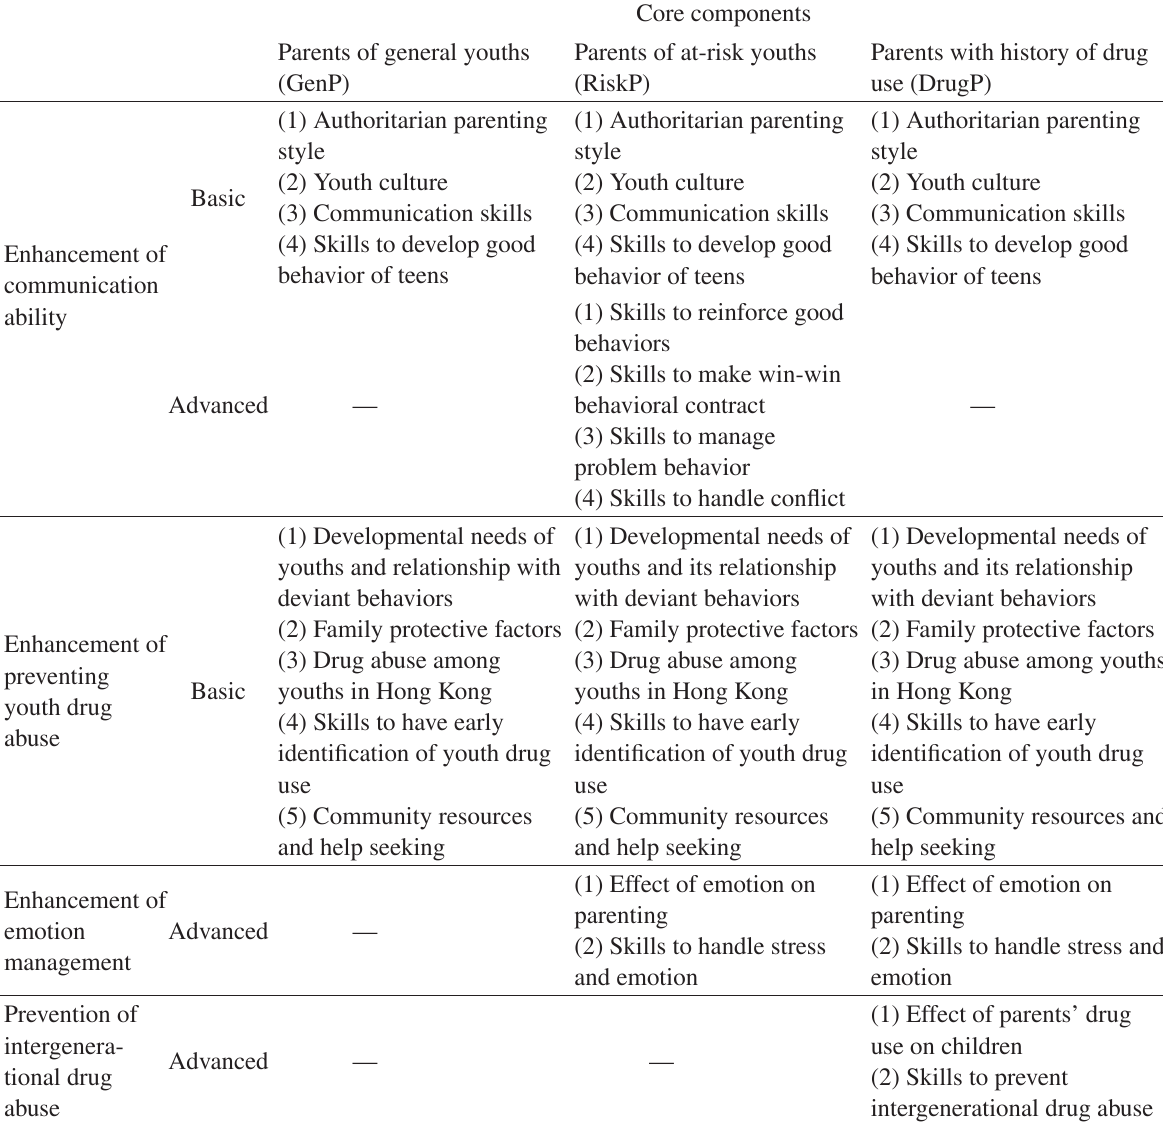
TABLE 1: Core components of the 3-level parent education